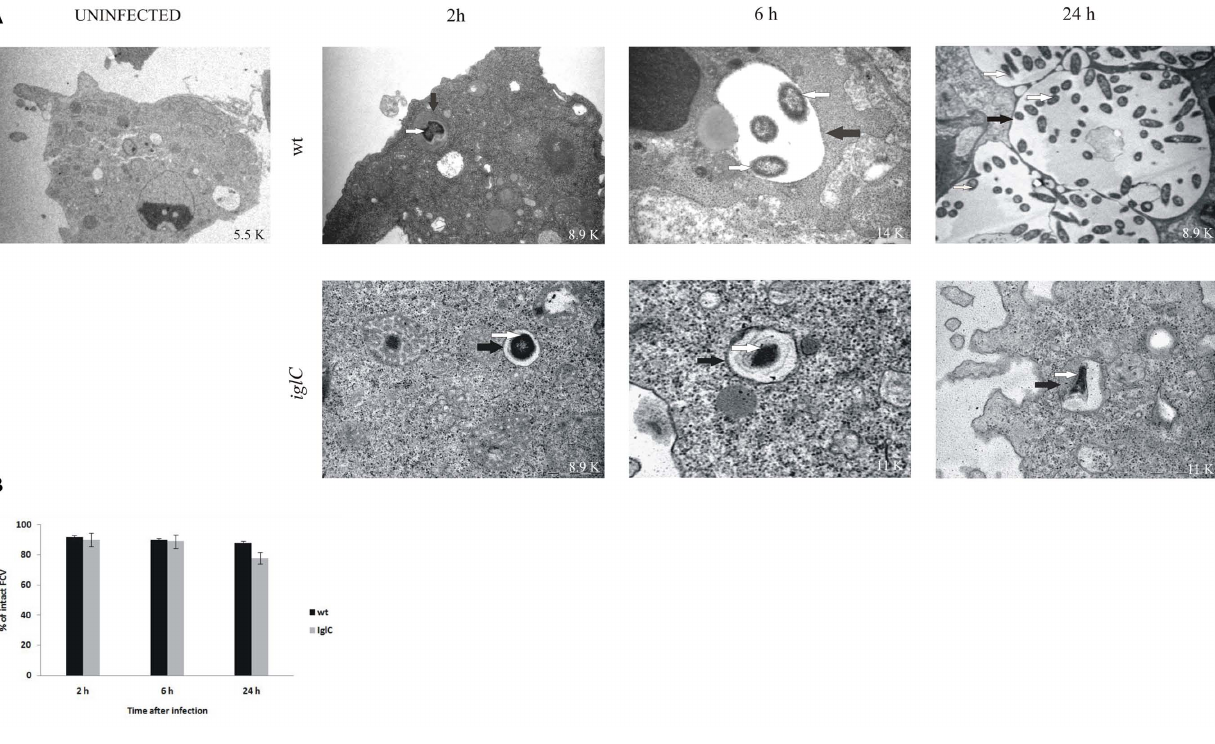
Figure 2 | Francisella novicida replicates in vacuoles of H. vermiformis. (A) Representative electron micrographs of H. vermiformis infected with wt F. tularensis subsp. novicida or the iglC mutant at 2, 6, and 24 h after infection. Thin black arrows show intact vacuolar membranes and white